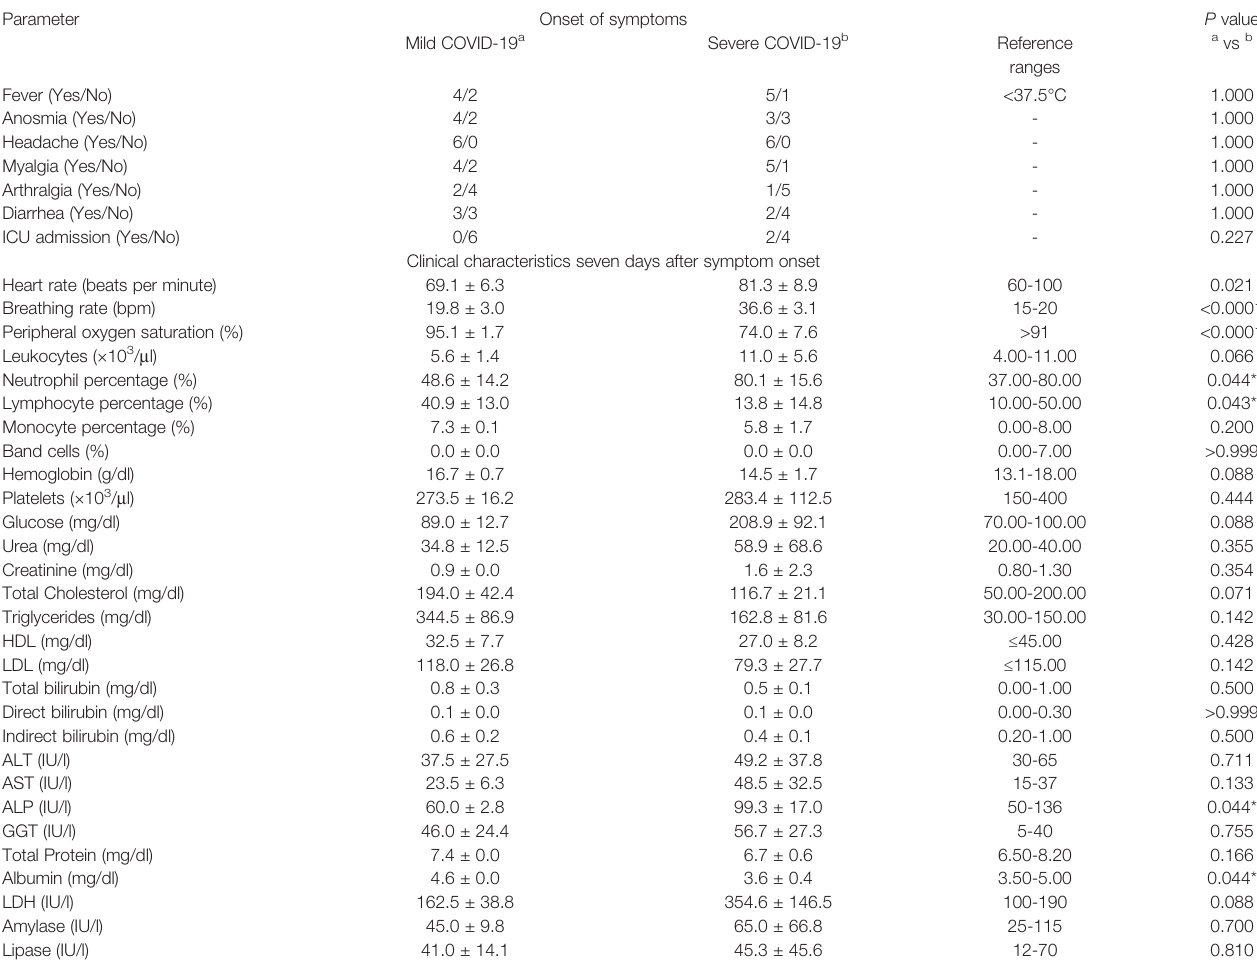
TABLE 2 | Clinical and biochemical characteristics of participants who developed mild or severe COVID-19 during the six-month follow-up. Parameter Onset of symptoms P value